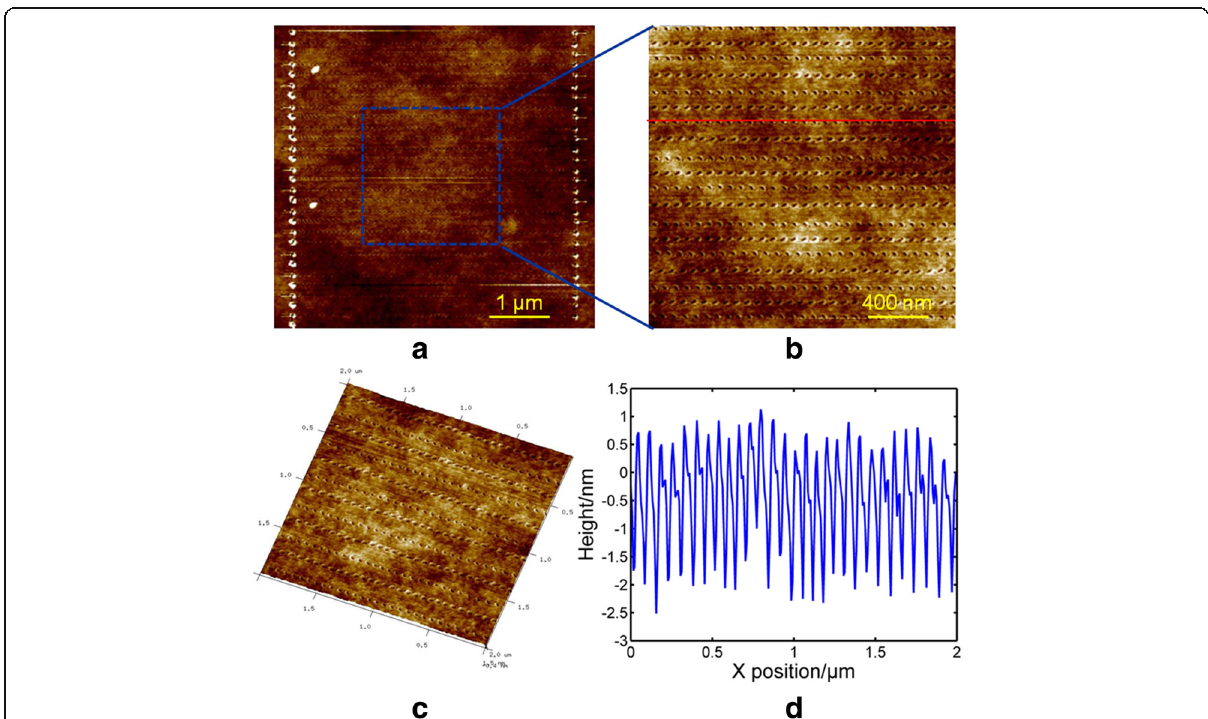
Fig. 7 AFM images of an array of pits with a scratching velocity of 400 μ m/s, a a dimension of 5 μ m, b a portion of a with a dimension of 2 μ m, c a 3D AFM image of b , and d a cross-section of pits for the red line in